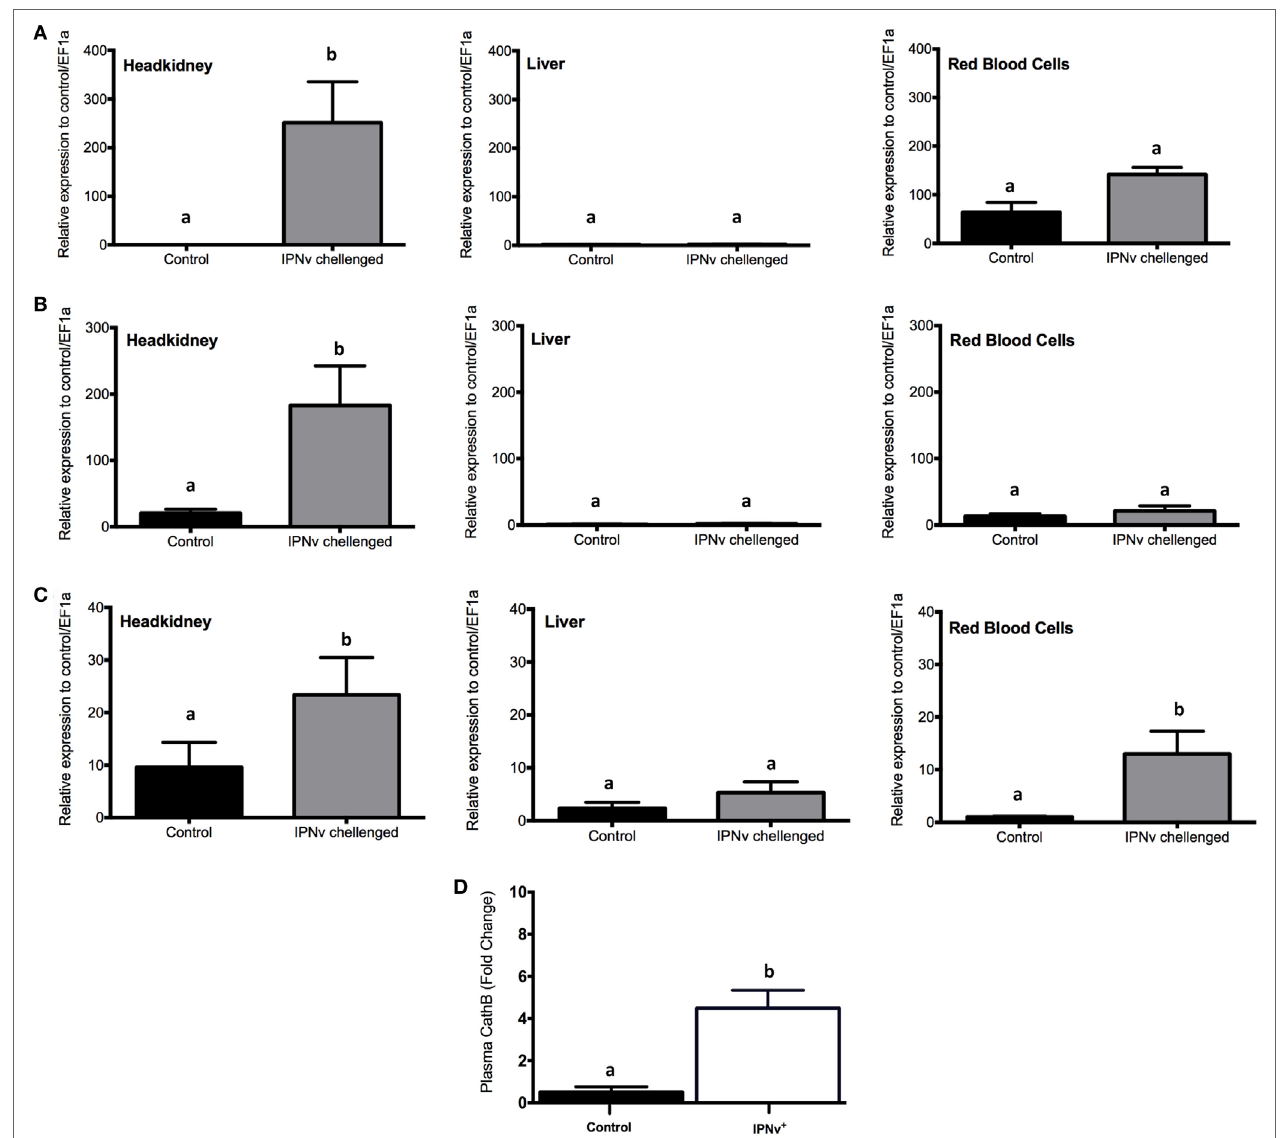
FigUre 3 | Expression profile of genes associated with antiviral responses. mRNA expression measured by qRT-PCR for (a) Mx, (B) IFN-y, and (c) cathelicidin from headkidney (left), Liver (middle), and red blood cells (right). (D) Salmo salar plasma concentration (pg × mL − 1 ) of Cathelicidin. The experimental groups are: virus free (control, black bar), infectious pancreaticc necrosis virus challenged (gray bar). Values are represented as the mean mRNA/protein abundance ± SD. Different letters denote significant differences between groups (two-way ANOVA; p < 0.05; p <